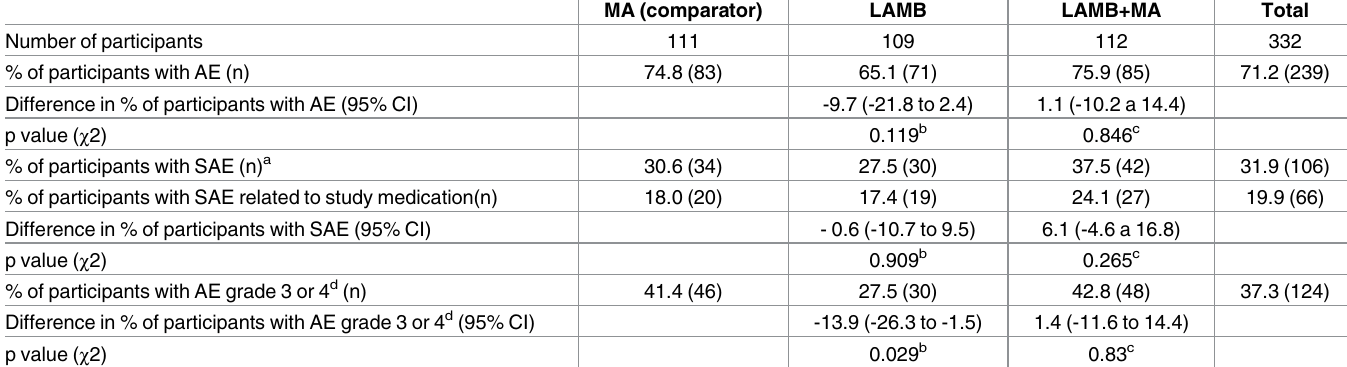
Table 5. Proportion of participants presenting at least one related AE, SAE and AE grade 3 and 4 per intervention